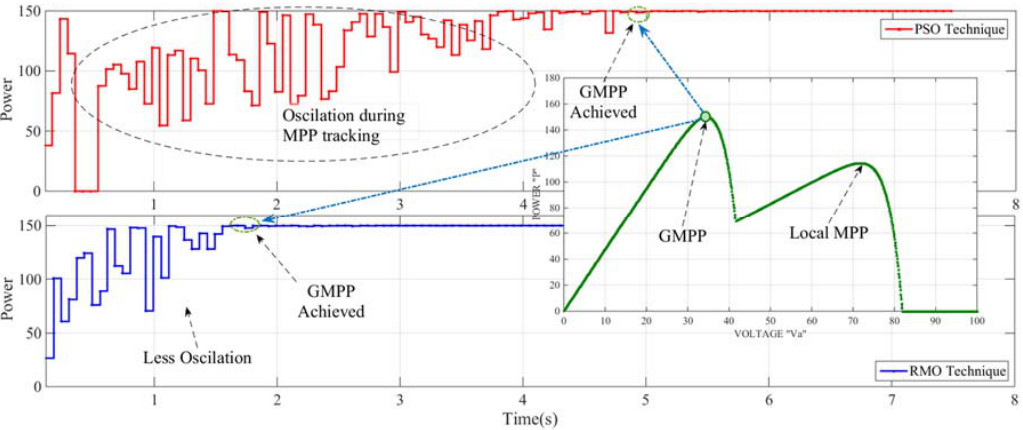
Figure 10. The output results of the proposed method and PSO method under shading condition for the first scenario.